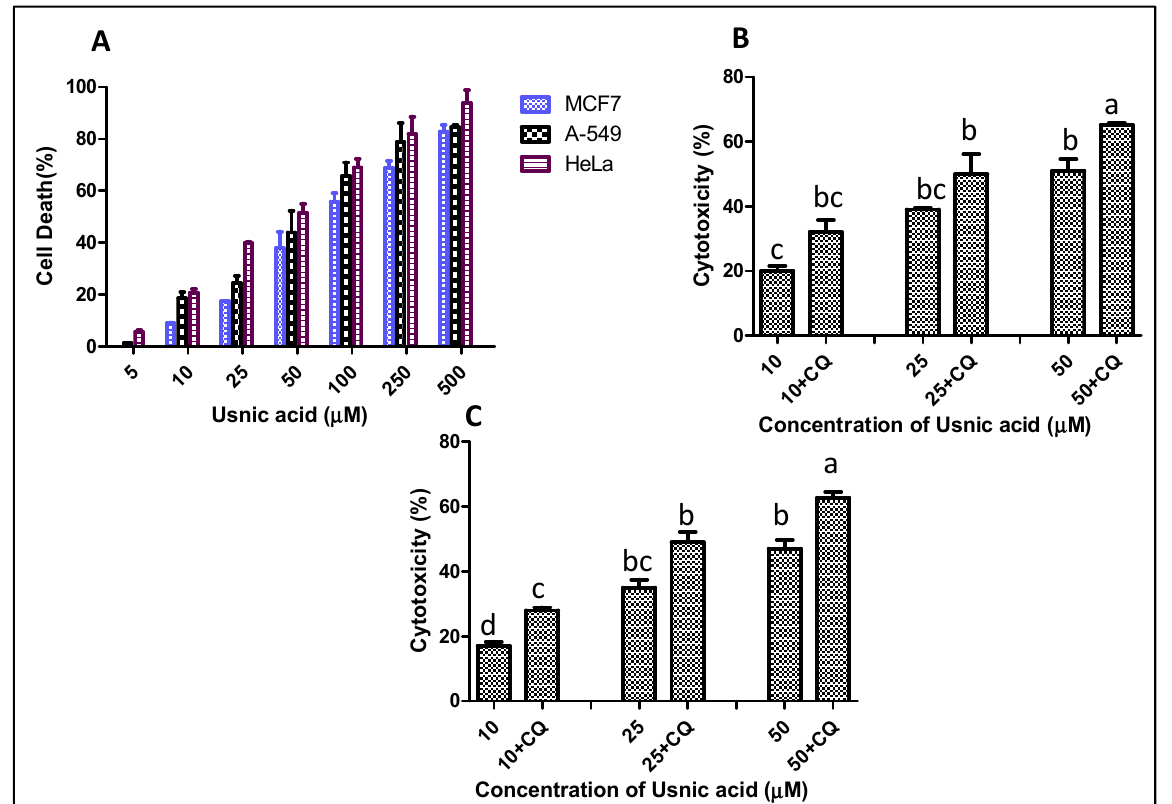
Figure 4. Concentration-dependent cytotoxicity of usnic acid against cancer cell lines after 24 h of treatment. ( A ) Cytotoxicity of usnic acid against MCF-7, A-549 and HeLa cancer cell lines. ( B ) Cytotoxicity of usnic acid in the presence of chloroquine (+/ − CQ) via an MTT assay. ( C ) Cytotoxicity of usnic acid in the presence of chloroquine (+/ − CQ) via a resazurin assay. Values are the means ± SD of three independent experiments. Means sharing different letters differ significantly from each other at p ≤ 0.05.